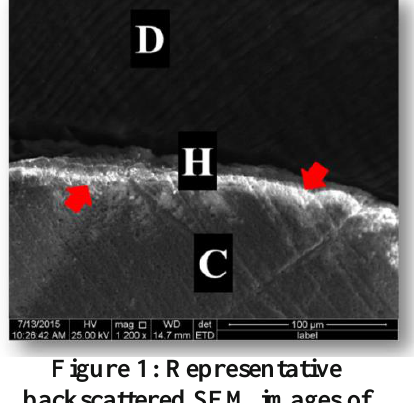
Figure 1: Representative backscattered SEM images of the resin–dentine interfaces of group (I) only laser surface conditioning. (C composite, H hybrid layer, D dentine, red arrow refer to